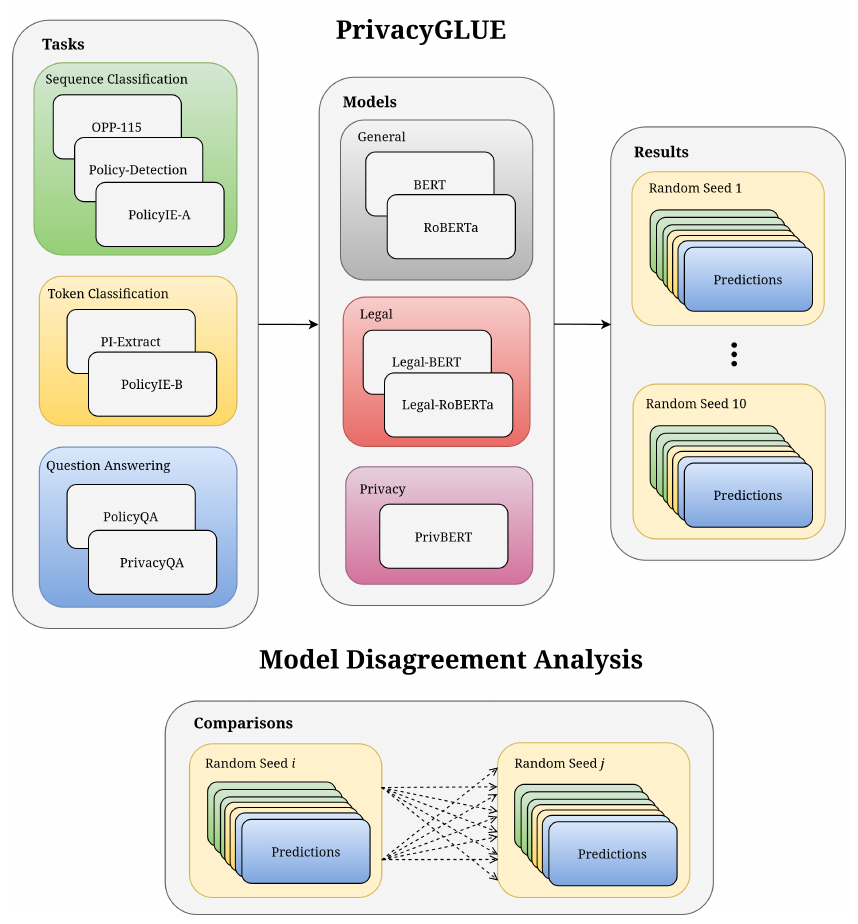
Figure 2. Flowchart depicting our main contributions, that is, the PrivacyGLUE benchmark with its tasks and models, along with the model disagreement analysis proposed in our